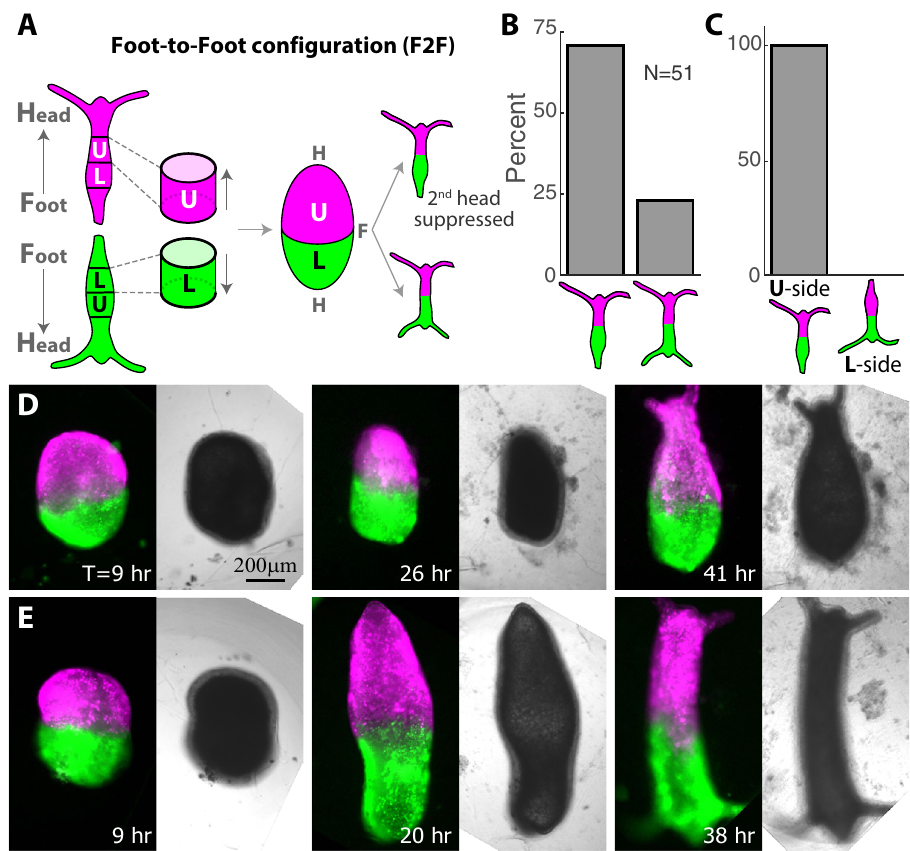
Figure 3. Position-dependent inhibition of second head formation in regenerating Foot-to-Foot (F2F) ring doublets. ( A ) Schematic illustration of the regeneration experiments with fused ring doublets in the F2F configuration. Rings are excised from above (U) or below (L) the approximated midpoint of animals that are differentially labeled (green/magenta). Two rings from different positions (U and L) are fused to each other at their foot-facing sides, and the regeneration is followed over time. ( B ) Bar plot depicting the outcome morphologies of fused ring doublets generated in the F2F configuration. Experiments were performed on 53 samples. 1/ 53 disintegrated, 1/53 did not regenerate and 51/53 regenerated into either a normal morphology with a single head, or an animal with two heads at both edges. All but 2/51 (i.e. 96%) of the regenerated animals fell into one of these categories. The percentages of regenerated animals in each category are depicted. ( C ) Bar plot showing the bias in head formation depending on the original position of the excised tissue rings (U or L). The original position of the excised ring on the side of the tissue where a head appeared was recorded for all F2F ring doublets that regenerated into an animal with a single head. In all these samples (36/36), invariably, the head formed on the U side. ( D ) Images from a time lapse movie of a F2F ring doublet that regenerated into an animal with a single head on the U side (Movie 5). ( E ) Images from a time lapse movie of a F2F ring doublet that regenerated into an animal with two heads on both sides (Movie 6). The panels in ( D , E ) depict combined epifluorescence (left; green—Texas Red-conjugated 3 kD dextran, magenta—AlexaFluor 647-conjugated 10 kD dextran) and bright-field (right) images at the specified time points during the regeneration (time after excision in